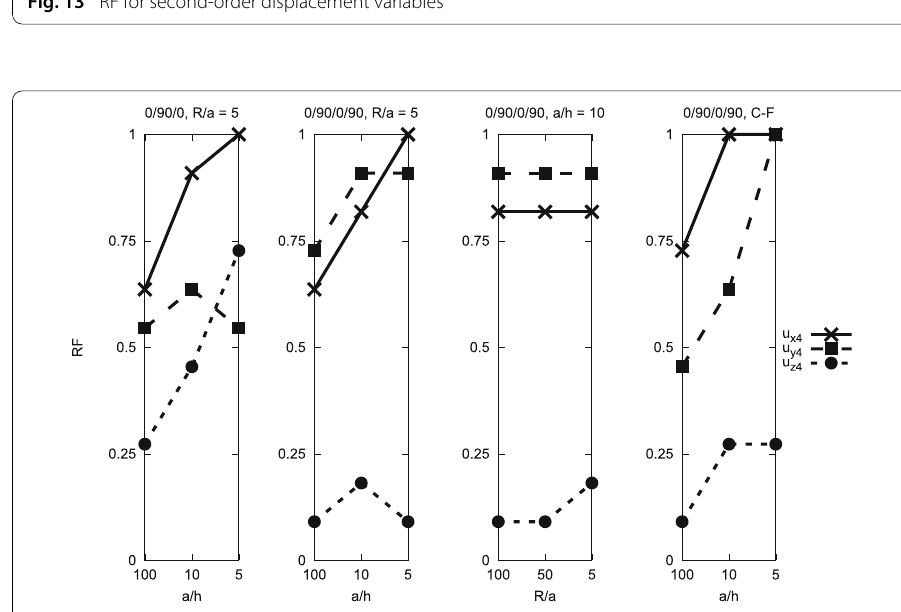
Fig. 14 RF for third-order displacement